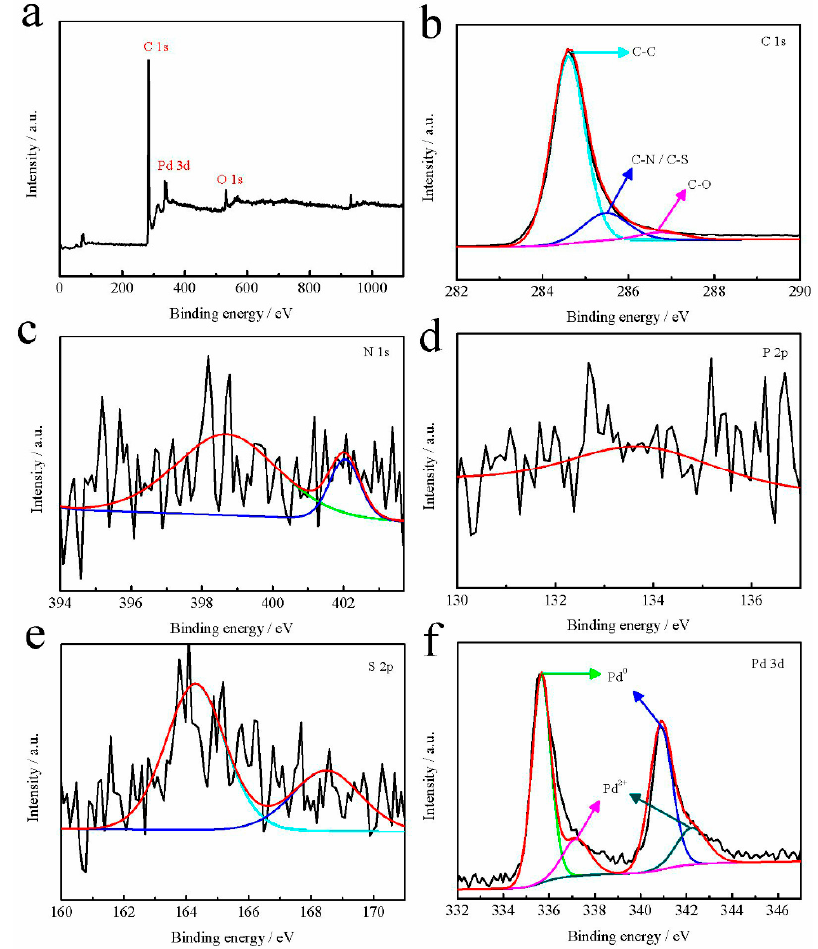
Figure 3. ( a ) X-ray photoelectron spectroscopy (XPS) surveys of the Pd/C–N,P,S catalyst and core- level spectra for ( b ) C 1s, ( c ) N 1s, ( d ) P 2p, ( e ) S 2p and ( f ) Pd 3d.